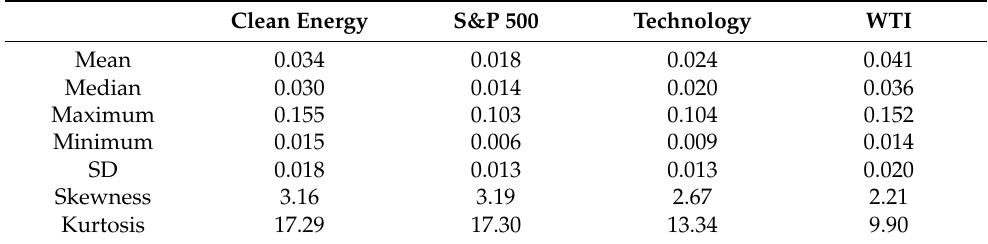
Table 1. Descriptive statistics of realized volatility among the clean energy (CE), S&P 500 (ST), technology (TE), and crude oil (WTI)